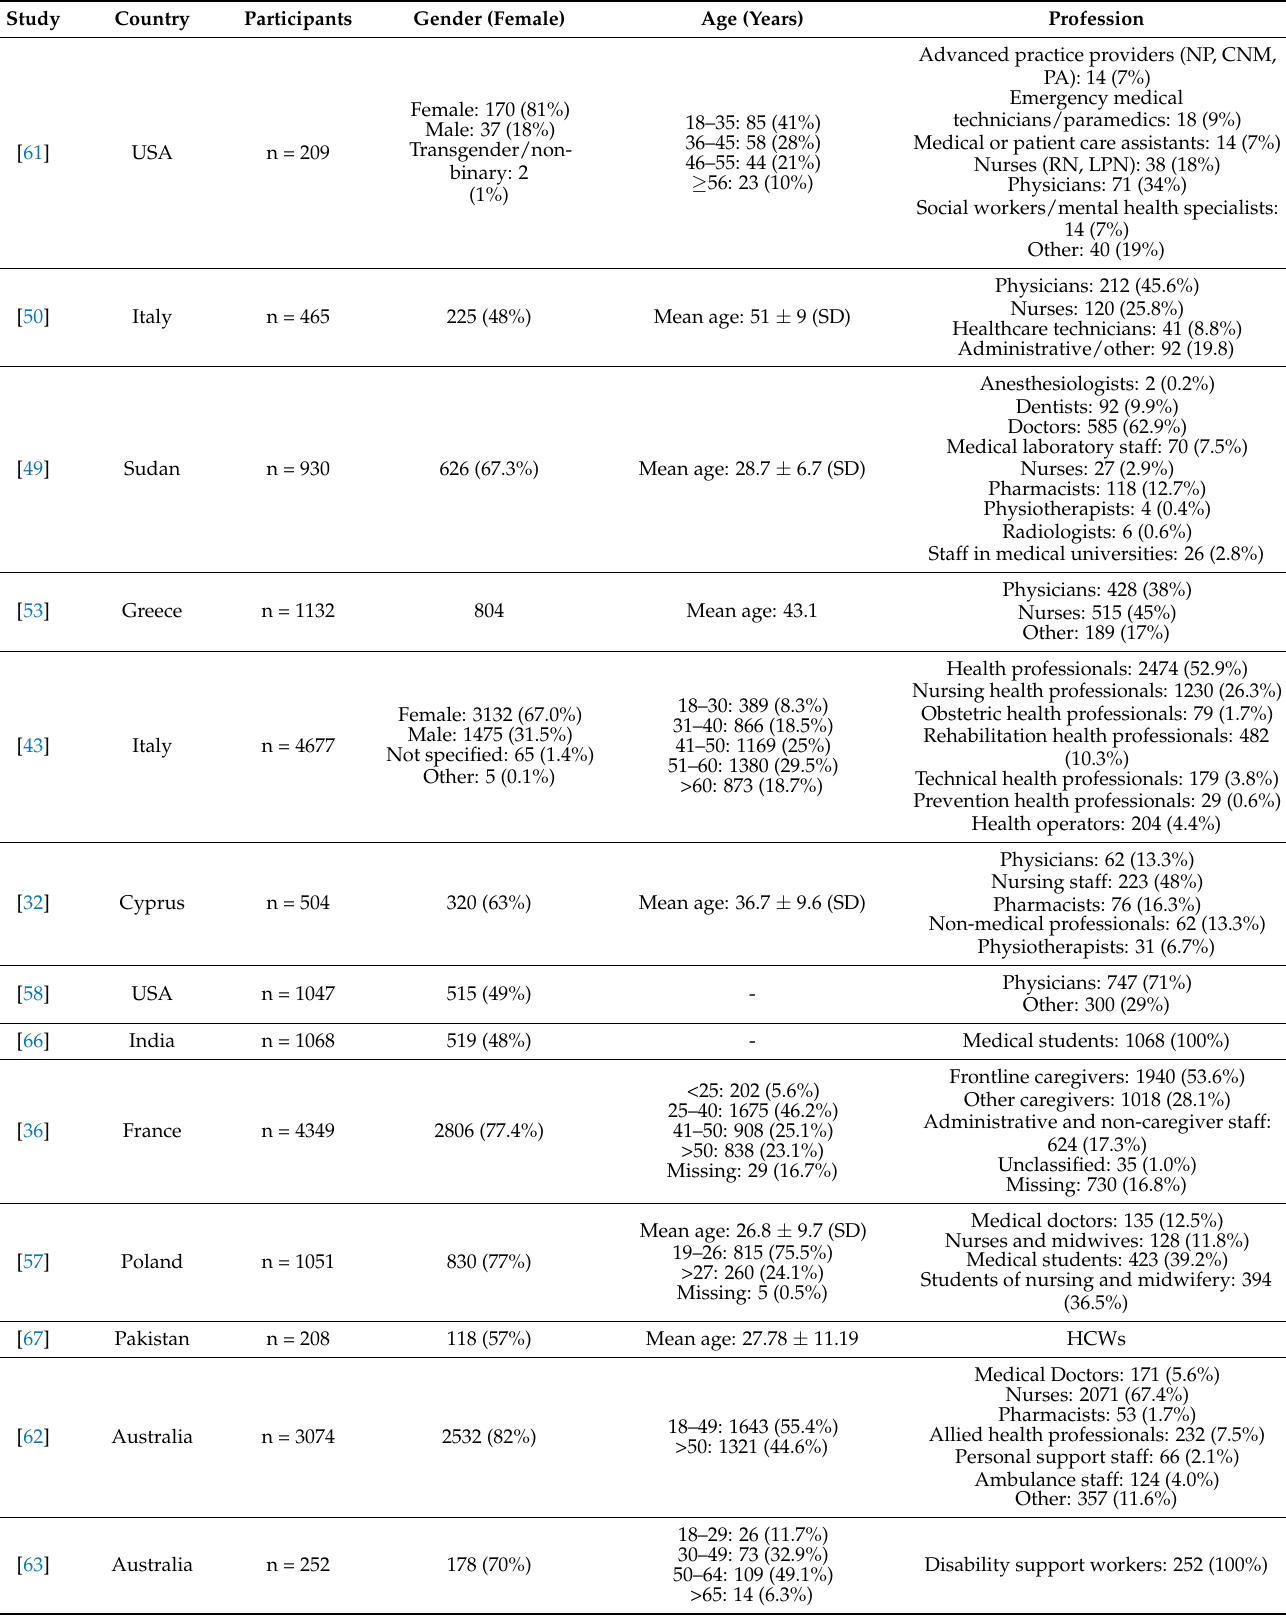
Table 2. Demographic features of the participants included in the meta-analysis: HCWs’ acceptance of COVID-19 vaccination mandates for